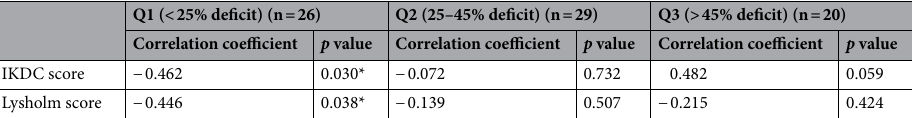
Table 3. Summary of partial correlation coefficients for subjective knee function at 1 year with preoperative knee extension strength deficit across groups. Age, height, weight, and body fat percentage were adjusted. Values are presented as median [IQR 25–75th percentile] if no otherwise specified. IKDC international knee documentation committee. * p < 0.05.